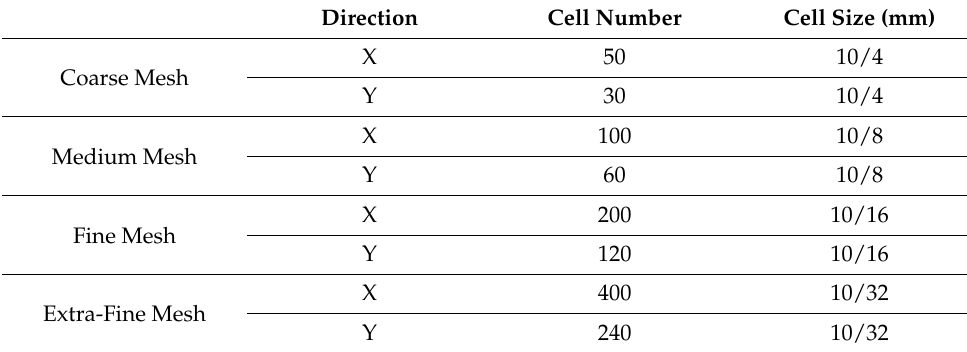
Table 3. Mesh Characteristics for the Energy-Diffusion Test.